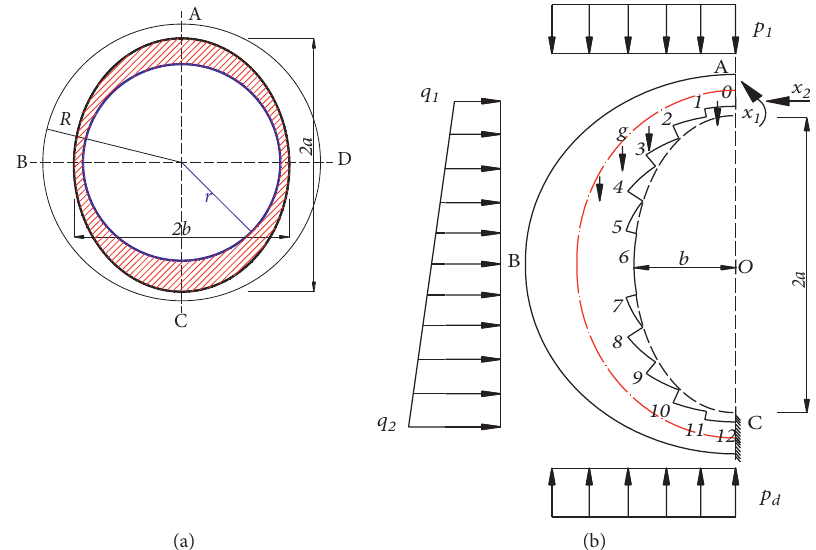
Figure 6: Outer circle and inner ellipse shield tunnel linings and stepwise basic structure. (a) Outer round inner oval shield tunnel lining. (b) Outer round inner oval shield tunnel lining with stepped basic